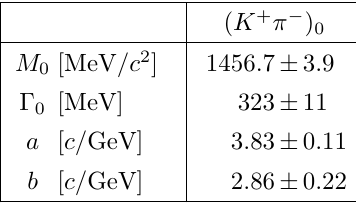
Table 5 . Alternative parameters of the LASS mass propagator used in the S-wave systematic uncertainty